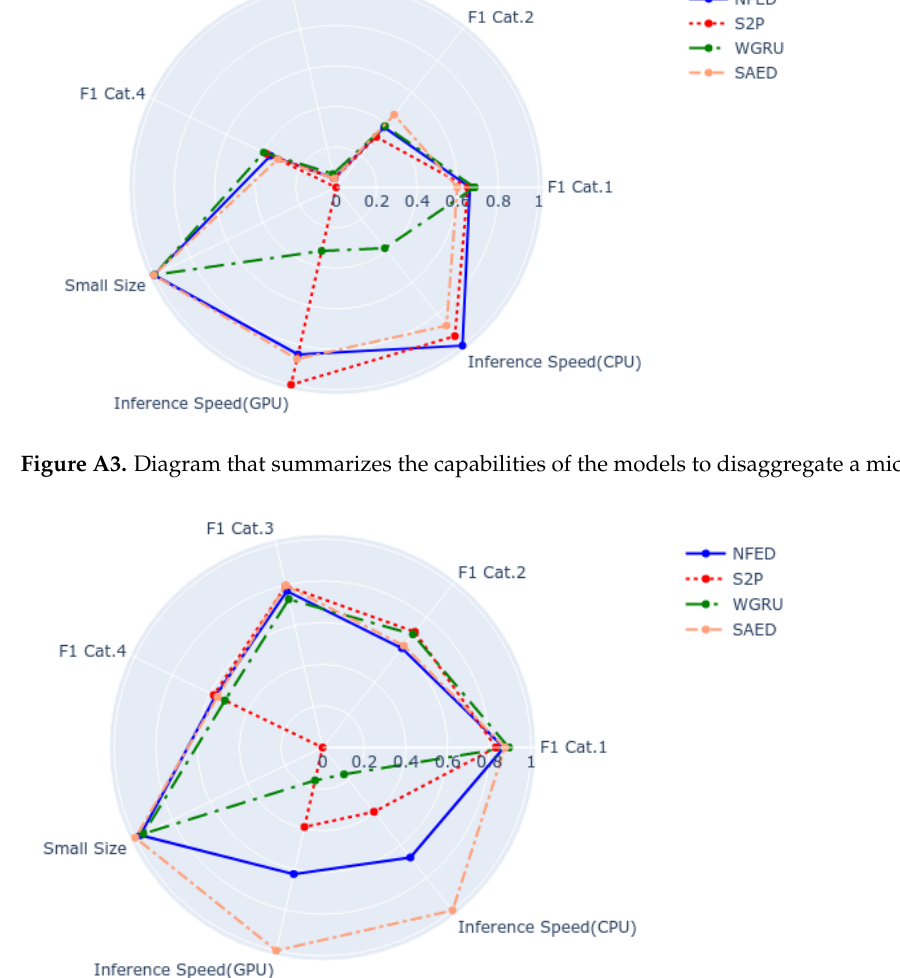
Figure A4. Diagram that summarizes the capabilities of the models to disaggregate a